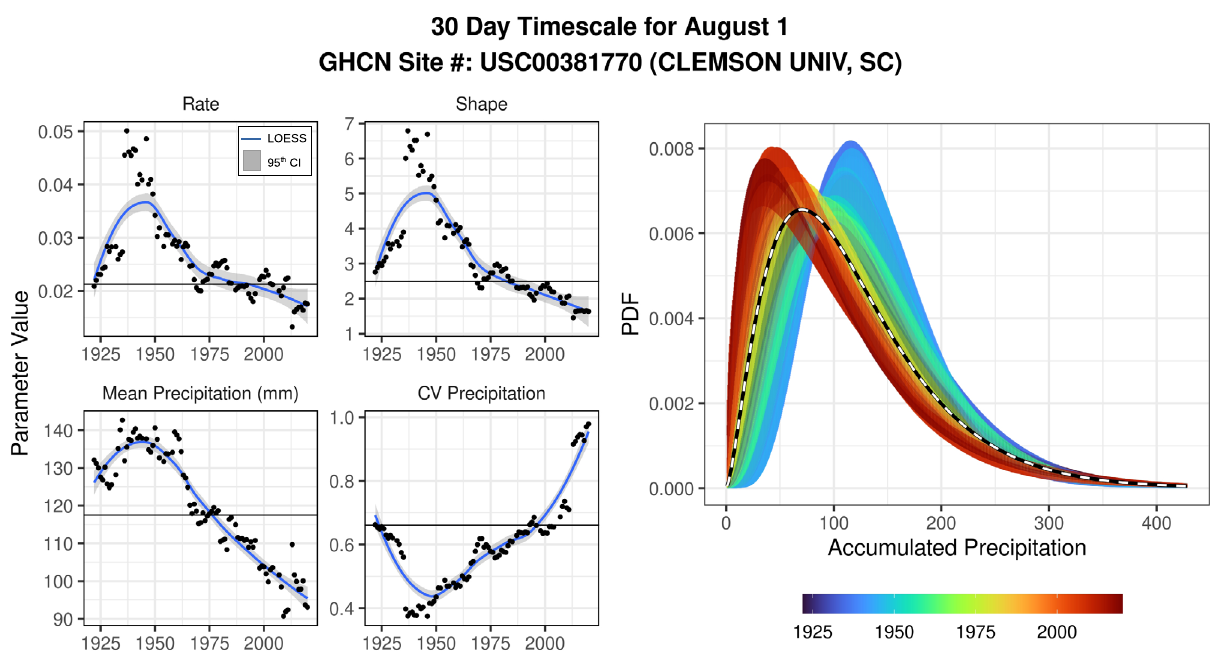
Fig. 2 Probability distribution shift for Global Historical Climatology Network (GHCN) site USC00381770 located at Clemson University in South Carolina. [left] Subplots show 30-year moving window values of the gamma distribution rate and shape parameters, mean precipitation and coef fi cient of variation (CV) of precipitation for a 30-day timescale on August 1st. Horizontal lines represent values computed using the temporally integrated distribution. [right] Probability density functions (PDFs) for each of the 30-year moving windows. The color scale represents the 30-year moving window ’ s fi nal year and the black and white dashed line represents the temporally integrated